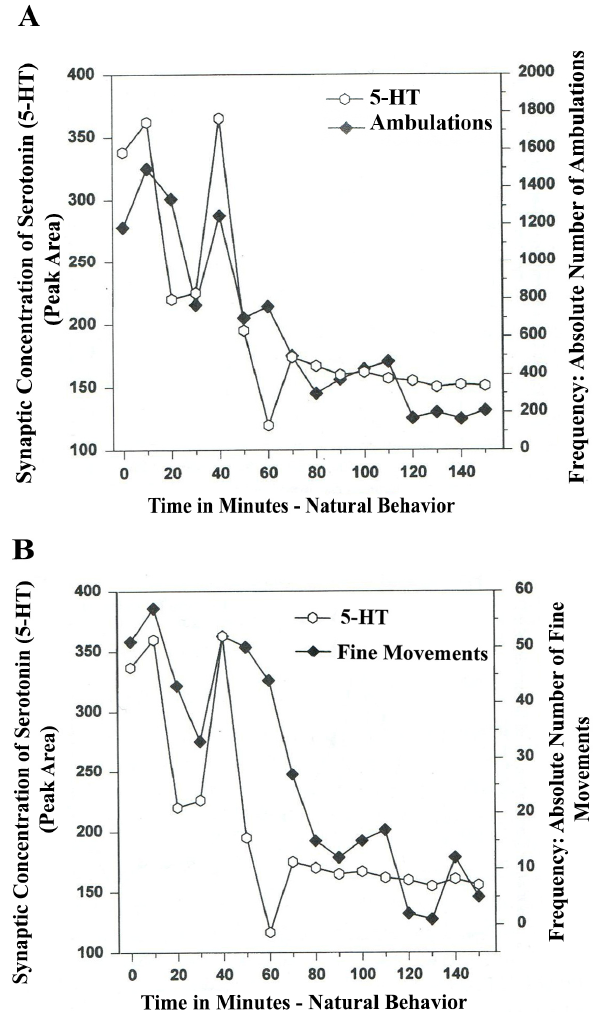
Figure 4. ( A ) Ambulations . Natural neurochemistry and behavior : line graph depicting endogenous 5-HT release (open circles) at basal nucleus, A terminals , vlNAcc , in real 10 time, while the freely moving, male, Sprague-Dawley laboratory rat is actually behaving, during normal/natural movement (first hour) and subsequent habituation behavior (second hour). ( B ) Fine Movements . Natural neurochemistry and behavior : Line graph depicting endogenous 5-HT release (open circles) at basal nucleus, A terminals , vlNAcc , 10 in real time, while the freely moving, male, Sprague-Dawley laboratory rat is actually behaving, during normal/natural movement (first hour) and subsequent habituation behavior (second hour). Note: the figure is adapted with permission from [21].